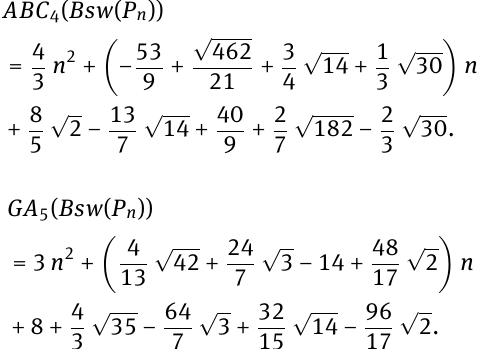
Table 4. We practice formulas (10) and (12) to the informa- tion provided in Table 4 and obtain the expected